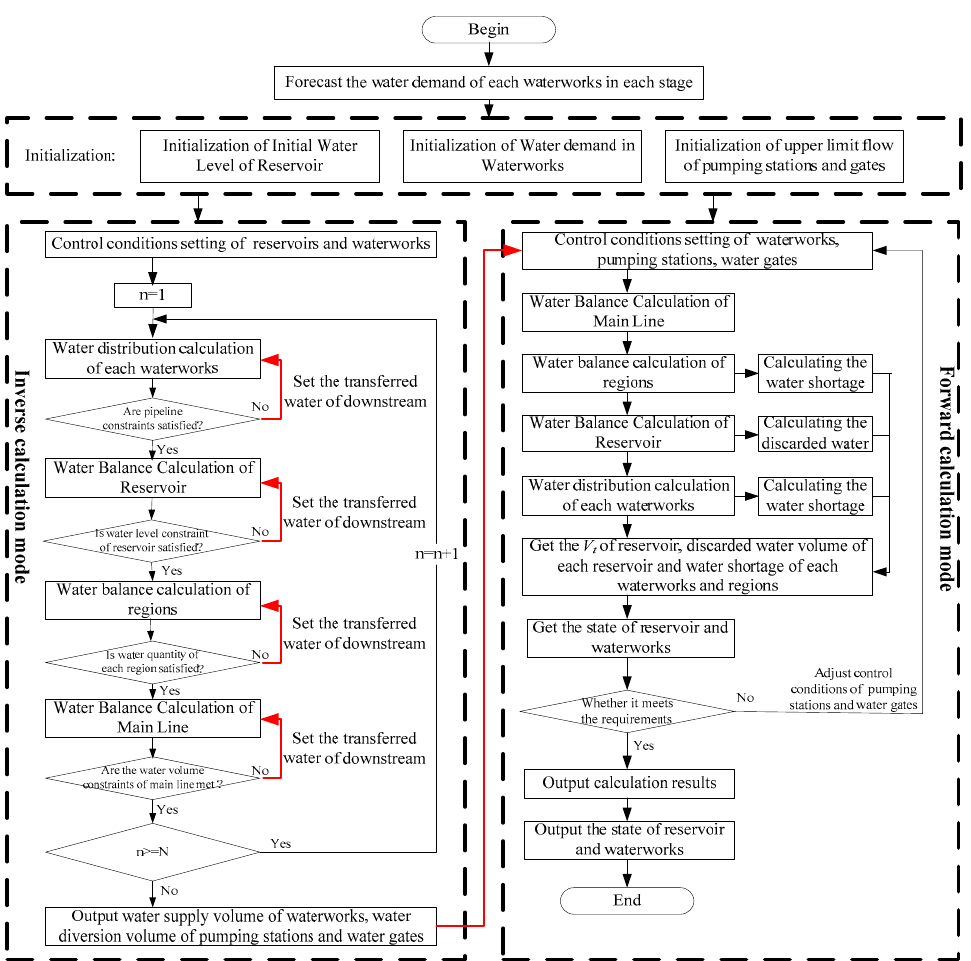
Figure 8. The double-layer feedback regulation based solving process of the dynamic simulation of the supply-demand balance.